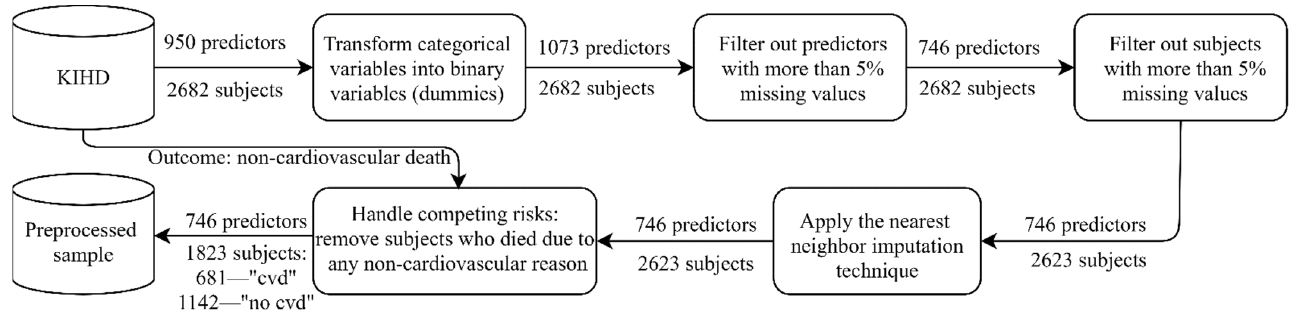
Figure 1. Preprocessing the sample from the Kuopio Ischemic Heart Disease Risk Factor Study (KIHD): “cvd” corresponds to “cardiovascular death by 2016”, while “no cvd” corresponds to “no cardiovascular death (alive) by 2016”. The nearest neighbor imputation technique implemented by Troyanskaya et al. was utilized [20].